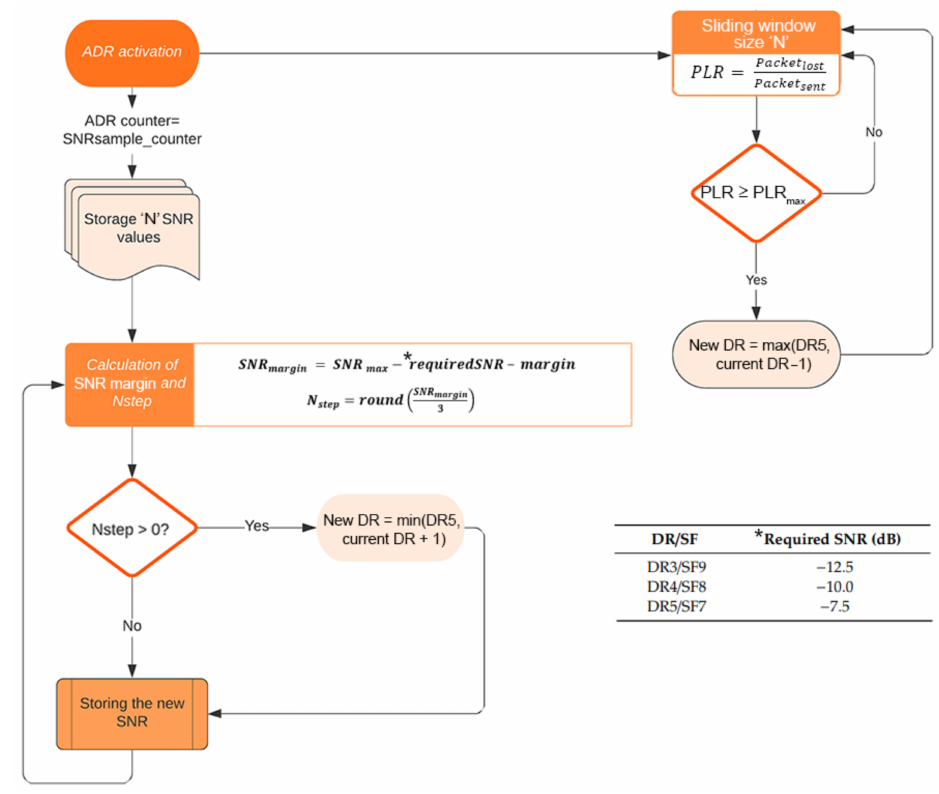
Figure 4. Proposed DROB mechanism overview for downlink.